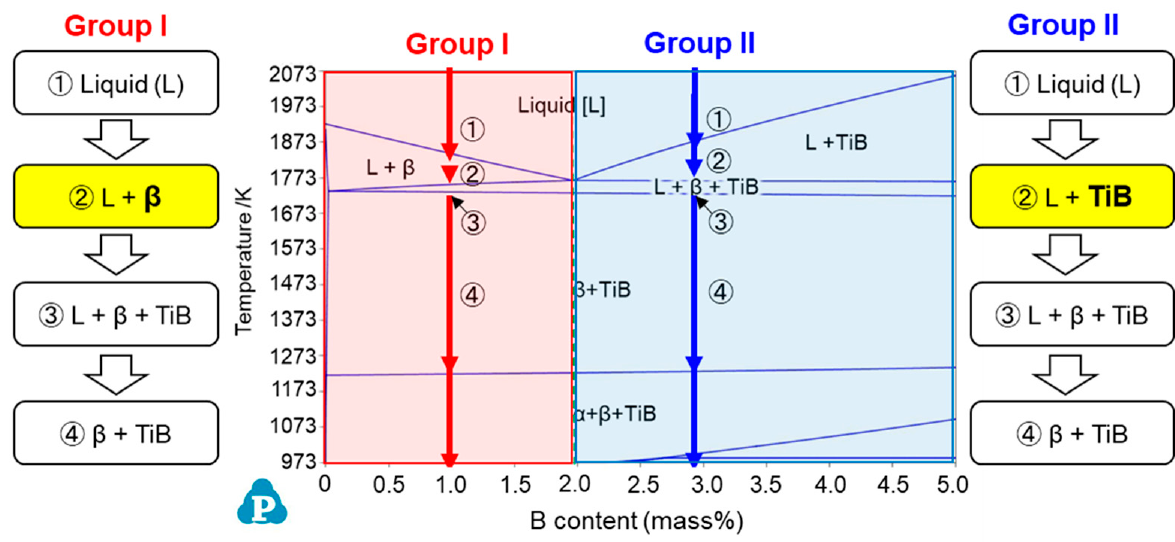
Figure 3. Calculated partial pseudo-binary phase diagram of (Ti-6Al-4V)- x B ( x = 0–5 mass%).